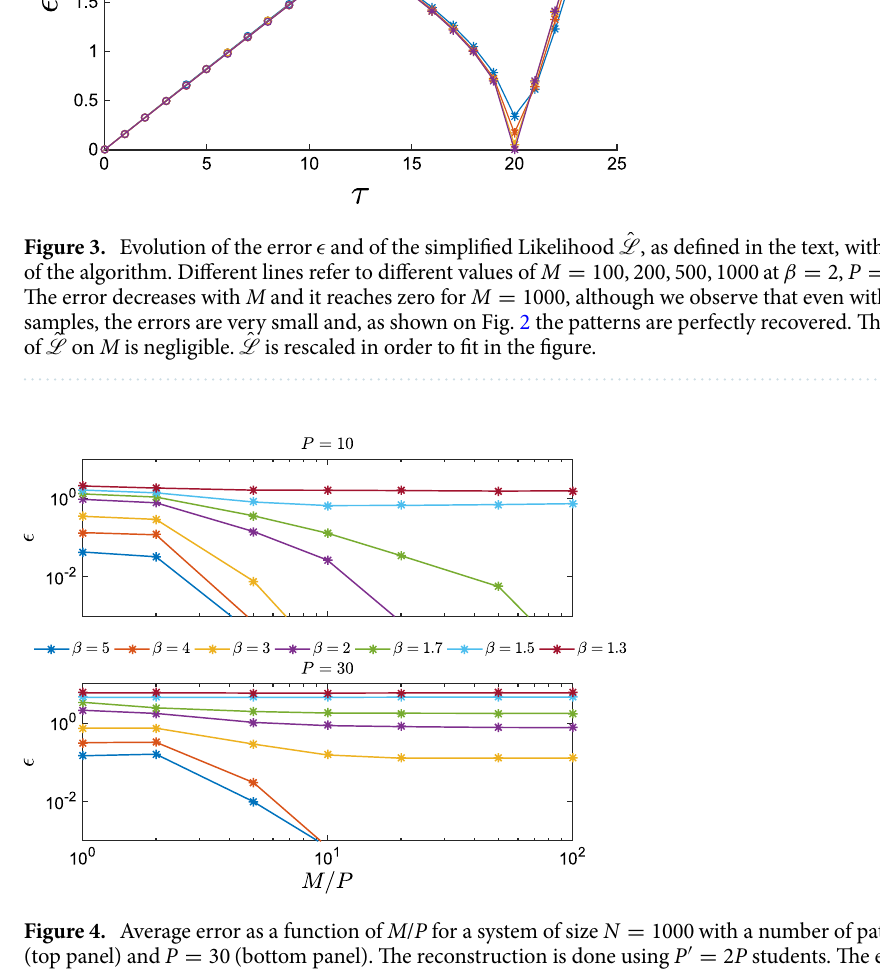
Figure 4. Average error as a function of M / P for a system of size N 30 (bottom panel). The reconstruction is done using P (top panel) and P = computed stopping the algorithm with the criterion described in the text. Each point represent an average over 100 independent trials. In the retrieval phase, the error goes to zero with M